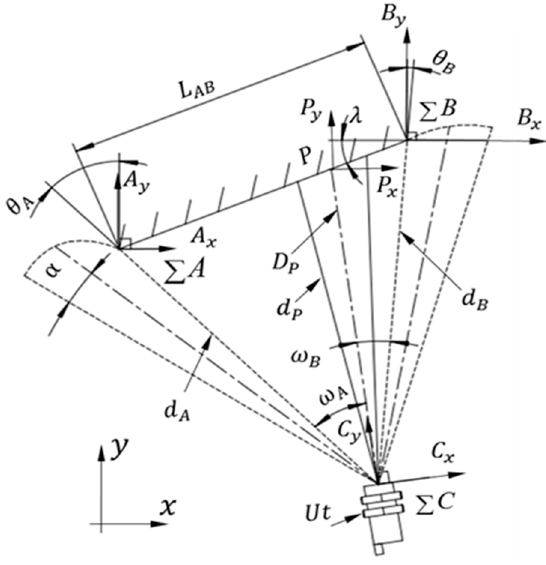
Figure 3. Edge detection of the inclined plate.